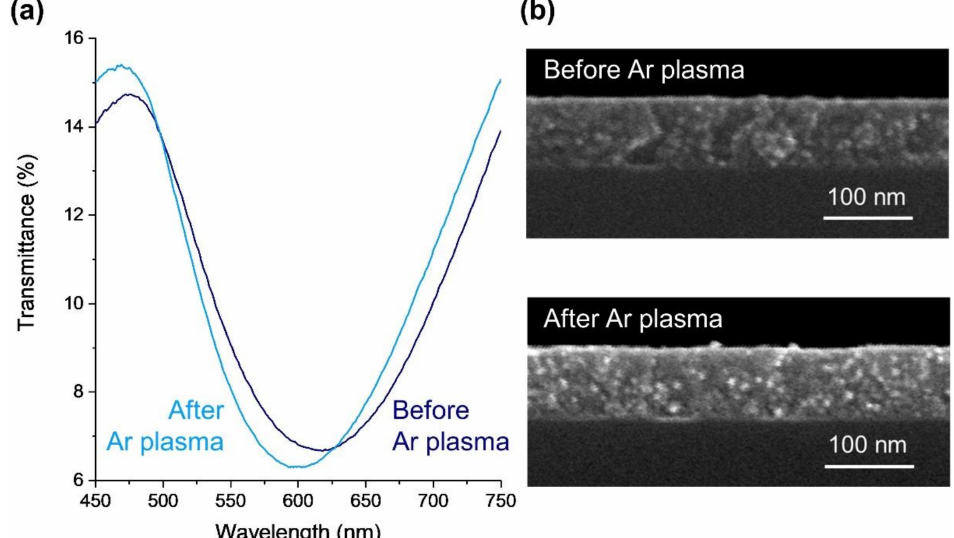
Figure 1. Effect of Ar plasma treatment on the optical and morphological properties of the Au-TiO 2 thin films annealed at 400 ◦ C: ( a ) optical transmittance spectra and ( b ) cross-section micrographs before and after Ar